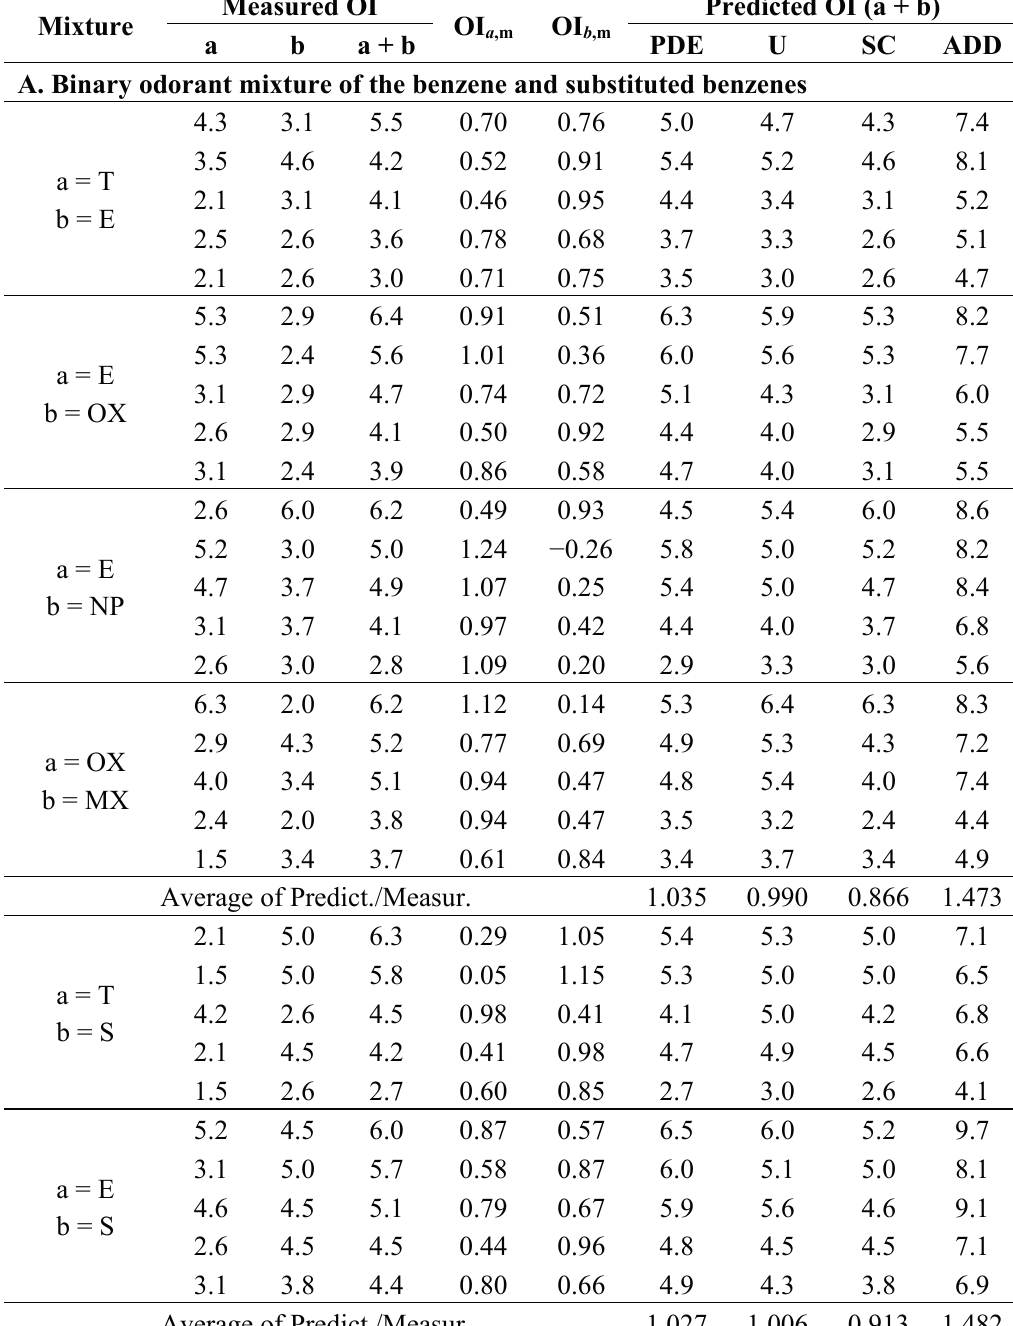
Table 3. Comparisons of odor intensity predictive performance among the extended PDE model, U model, SC model and ADD